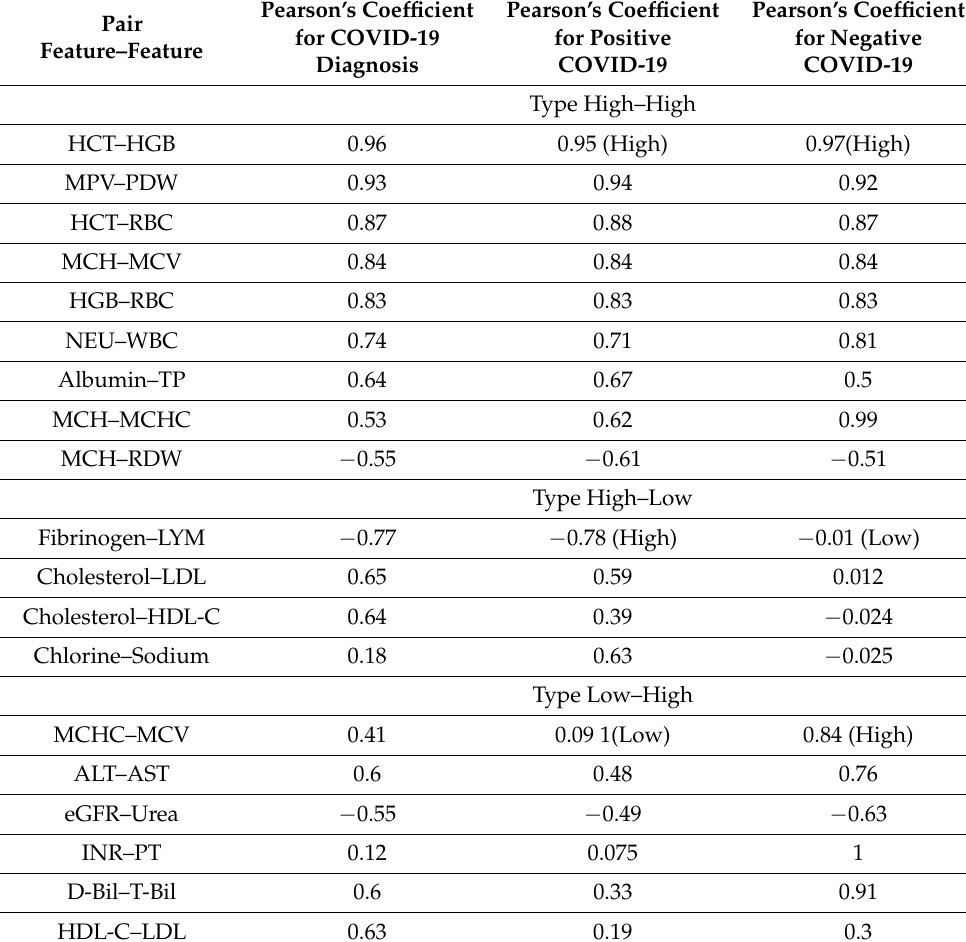
Table 4. The features most strongly correlated with each other by the Pearson coefficient for the entire database and separately for classes (positive or negative COVID-19